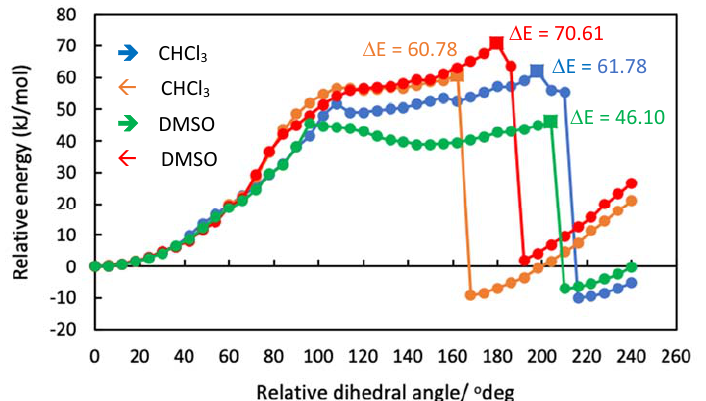
Figure 7. The relative total energies ( ∆ E) for the conformer all - out during dihedral angle changes (blue—the dihedral angle increases, CHCl 3 ; orange—the dihedral angle decreases, CHCl 3 ; green—the dihedral angle increases, DMSO; red—the dihedral angle decreases, DMSO). The maxima on each curve are marked with squares together with their values.